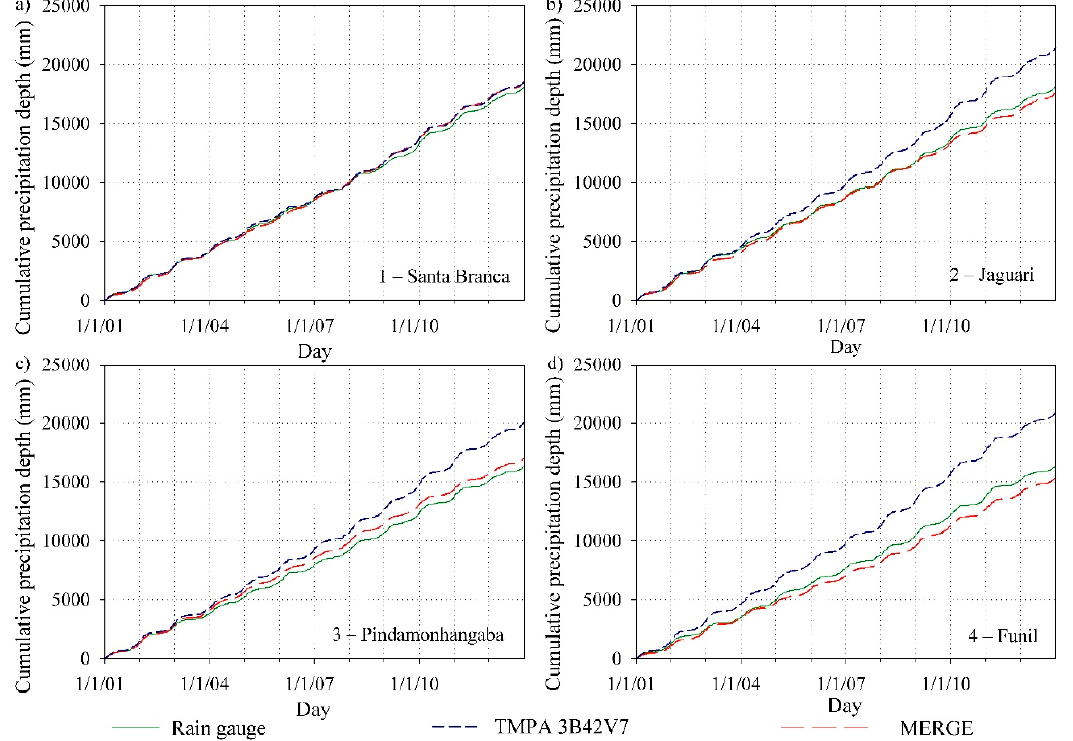
Figure 3. Cumulated precipitation depths for watersheds ( a ) 1, ( b ) 2, ( c ) 3, and ( d )